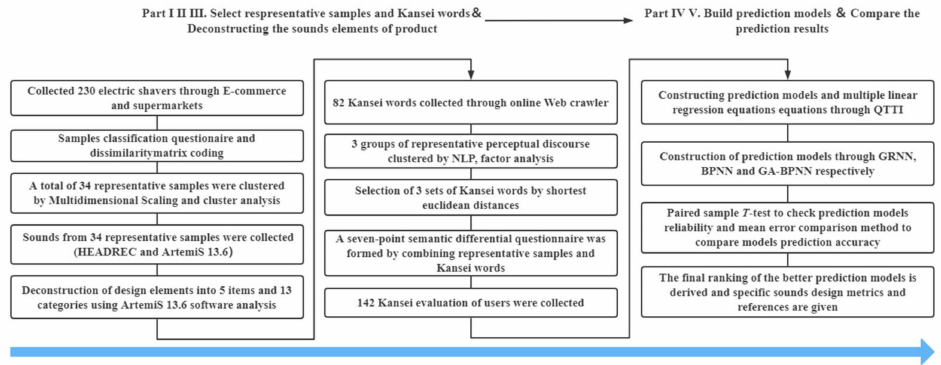
Figure 1. Research flow chart.